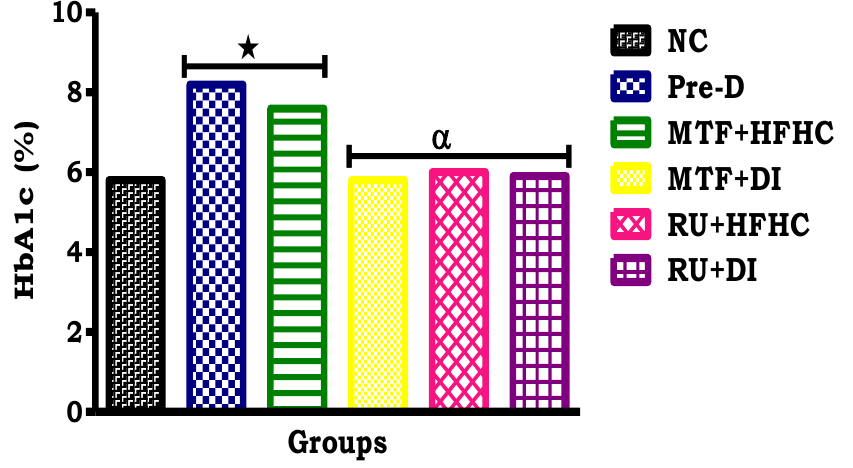
Figure 4. The effects of the ruthenium complex on terminal HbA1c concentration of pre-diabetic animals during treatment period. Values are presented as means ( n = 6) in each group. * p < 0.05 by comparison with normal control (NC), α p < 0.05 by comparison with pre-diabetic control (Pre-D);